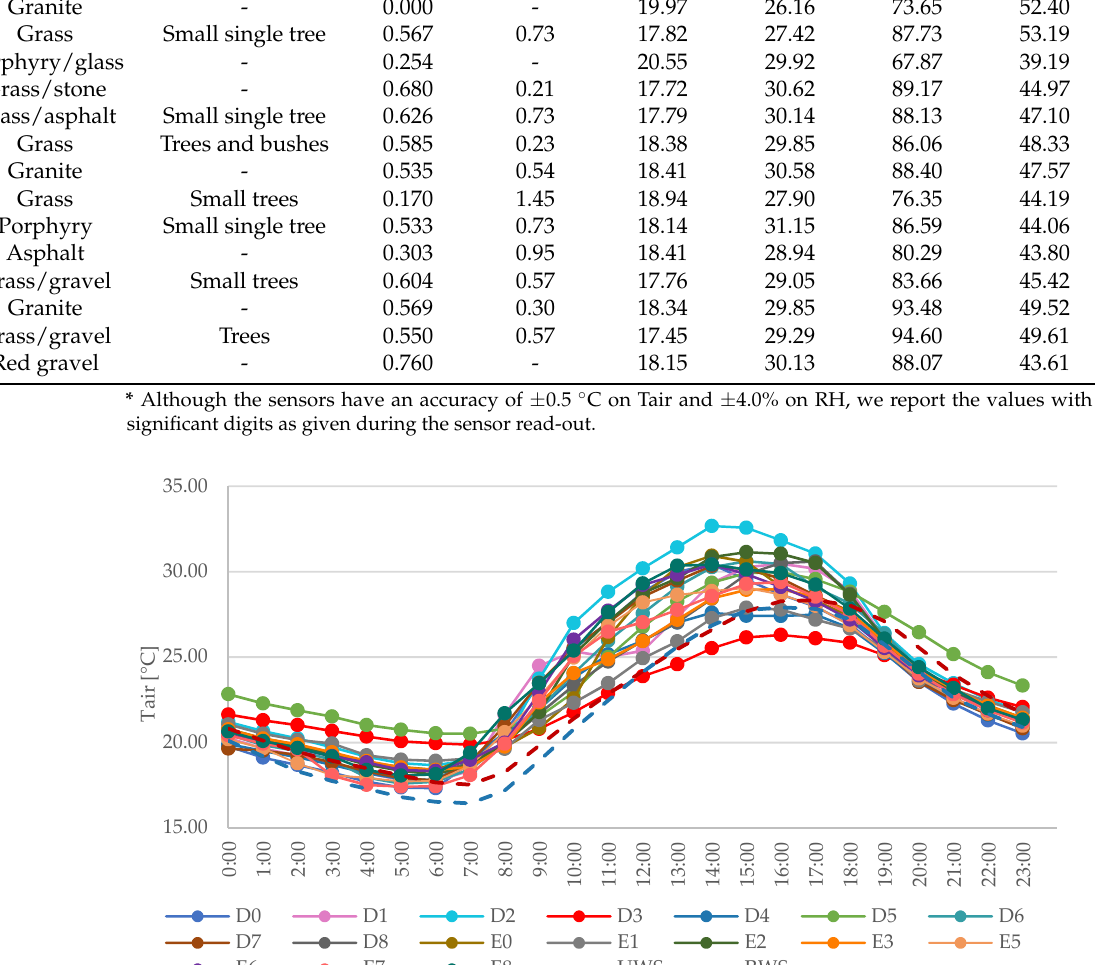
Figure 8. Hourly averaged air temperature recorded by the sensor nodes (solid) and by the South Tyrol Province urban (UWS) and rural (RWS) weather station (dashed) in the period 15 July–15